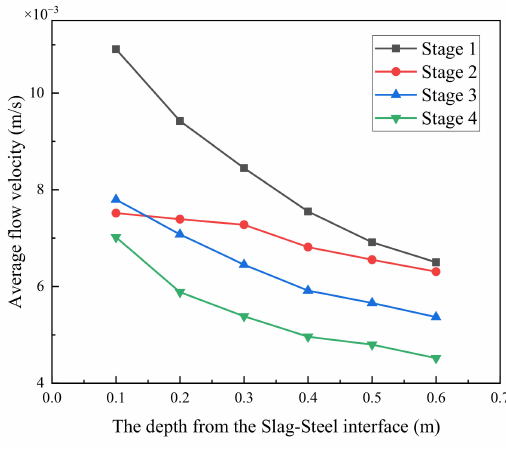
Figure 4. Speed distribution at each interface.